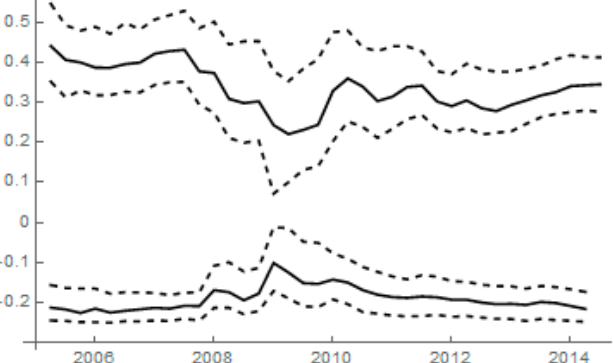
the top (bottom) curves. The solid line represents the median, the two dashed lines represent the first and third quartiles.